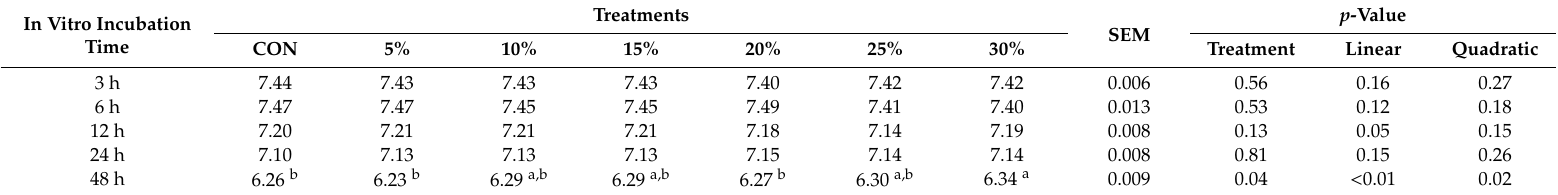
Table 7. E ff ects of di ff erent cassava residue substitution ratio for crushed maize on in vitro pH in dairy cows at mid-lactation. In Vitro Incubation